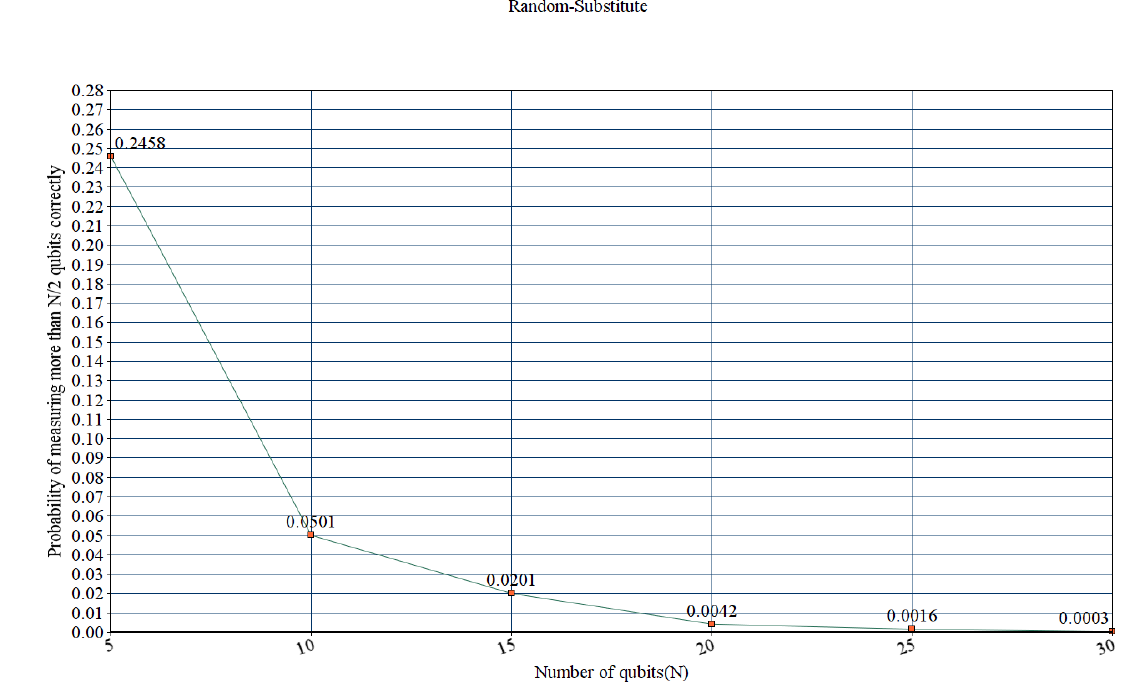
Figure 10. Probability that EVE measures more than half of the information correctly during Random Substitute